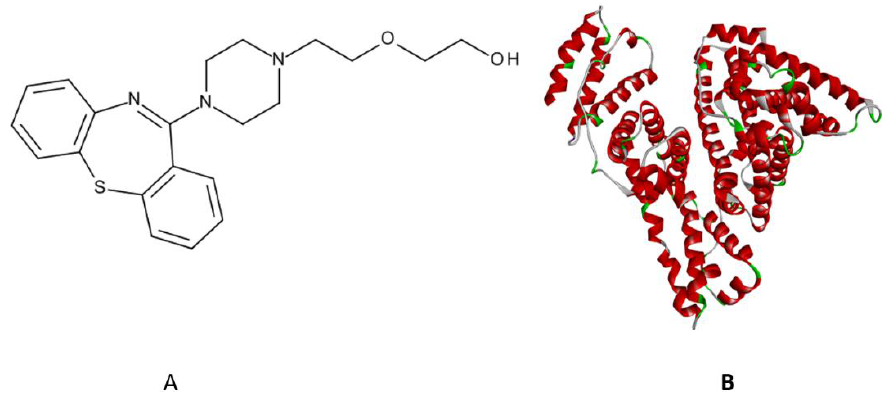
Figure 1. ( A ) chemical structure of QTP; ( B ) molecular structure of HSA.